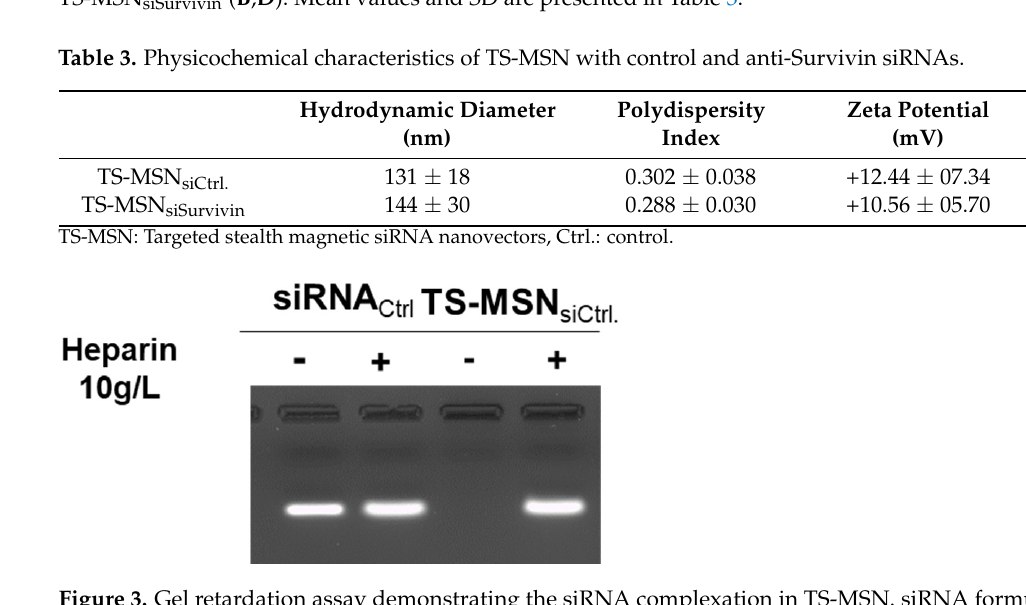
Figure 3. Gel retardation assay demonstrating the siRNA complexation in TS-MSN. siRNA formu- lated in TS-MSN in the presence (+) or absence (-) of heparin compared to naked siRNA. Lanes